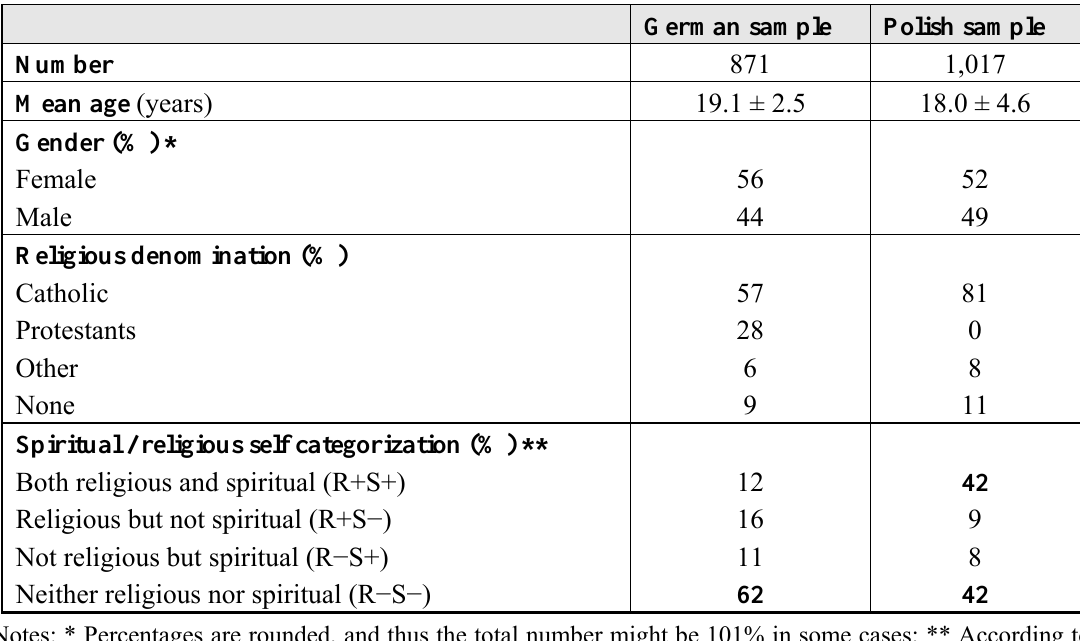
Table 1. Characteristics of German and Polish adolescents and young